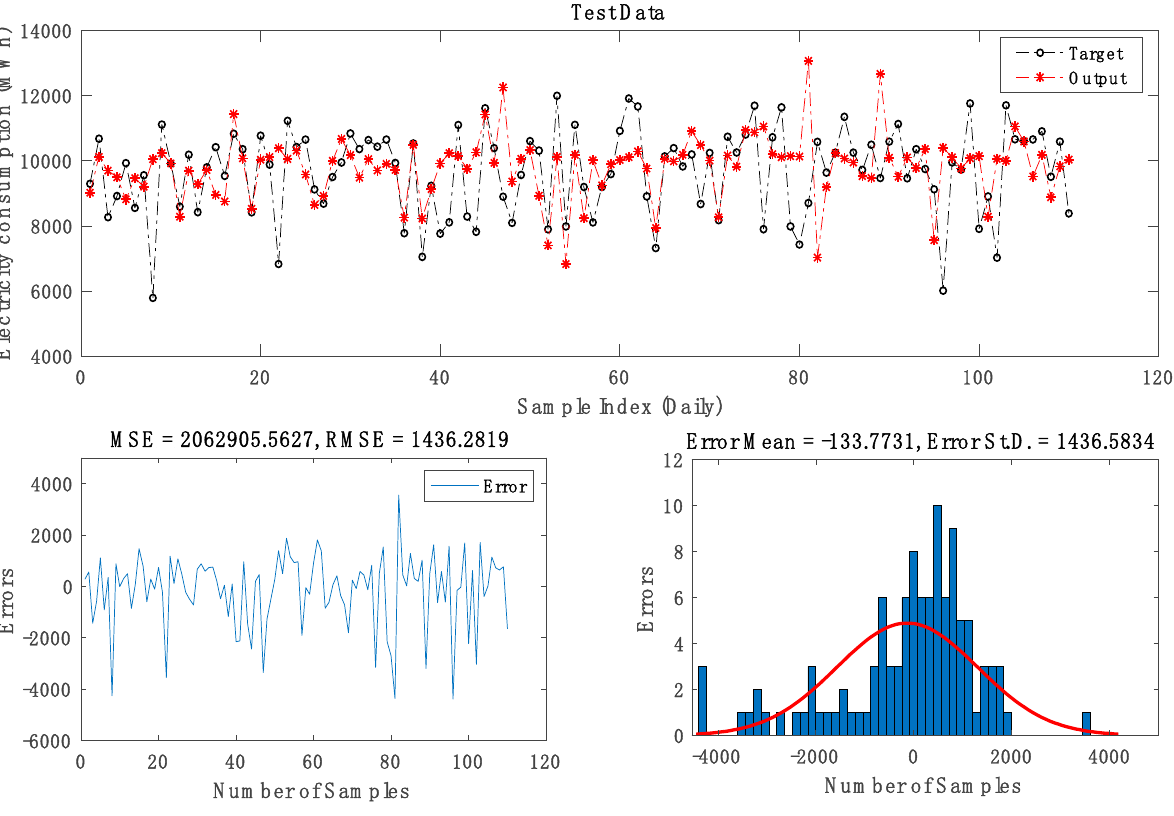
Figure 6. Optimal ANFIS-GP4 sub-model.